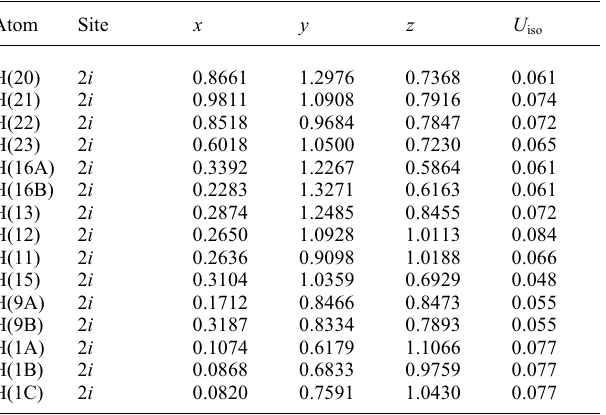
Table 2. Atomic coordinates and displacement parameters (in Å 2 )